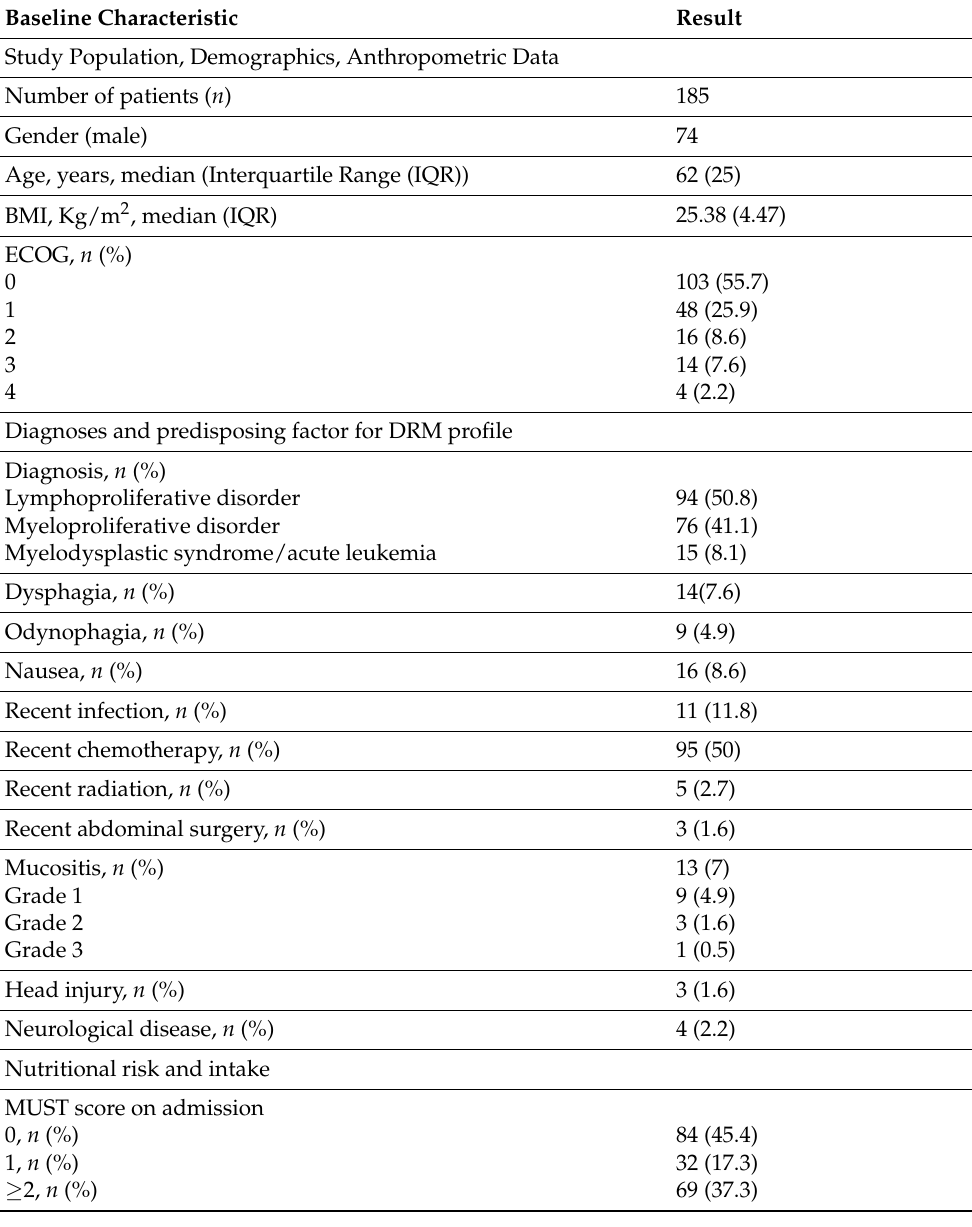
Table 1. Demographic, anthropometric, and disease characteristics of the audited